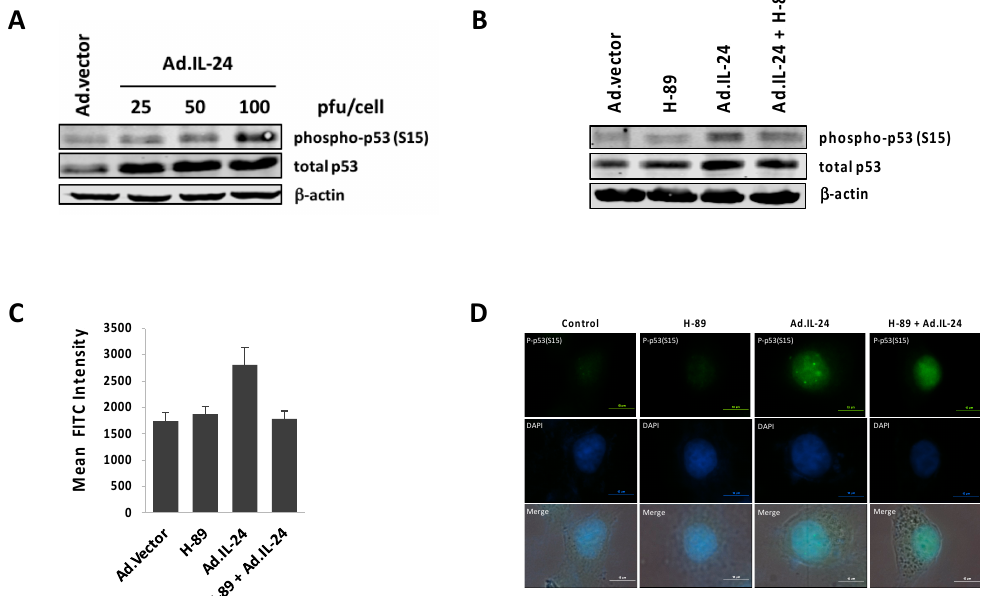
Figure 4. IL-24 induces TP53 expression, and promotes nuclear translocation in a PKA-dependent manner. ( A , B ) MCF-7 cells were treated for 72 h with Ad.IL-24 (25, 50, and 100 pfu per cell), 10 μ M H-89, or Ad.vector (100 pfu per cell). Cells were collected, protein purified, and subjected to Western blot analysis to detect to detect phospho-TP53, total TP53, and β -actin proteins. ( C ) Semi-quantitative measurements of the mean fluorescein isothiocyanate (FITC) intensity were taken using Nikon NIS Elements whereby, the average intensity of five cell nuclei were taken under each experimental condition. Error bars are expressed as the standard deviation of FITC intensity values. ( D ) Cells were fixed and phospho-Ser15 TP53 was detected by immunofluorescence using anti-phospho-TP53 antibodies.